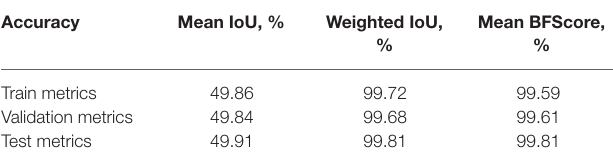
TABLE 11 | The performance metrics for image